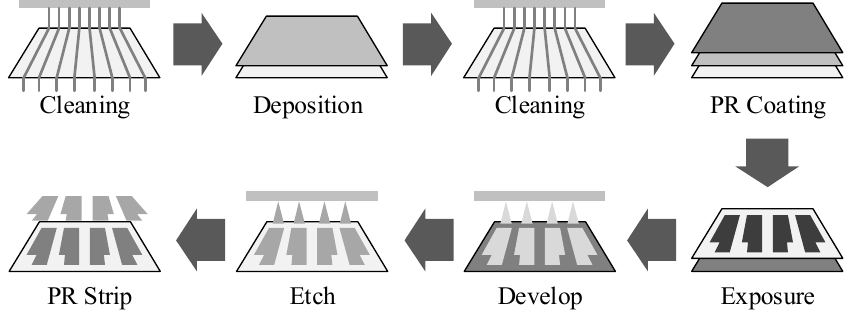
Figure 1. Overview of the thin film transistor (TFT)–liquid crystal display (LCD) manufacturing process.